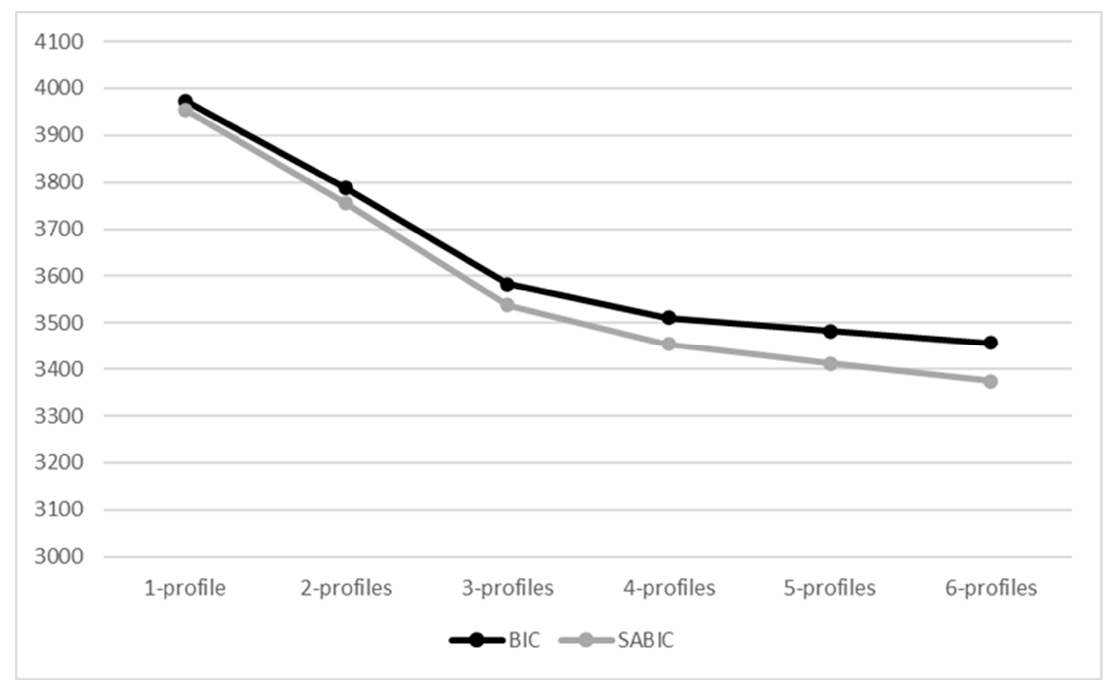
Figure A2. BIC and SABIC plots based on Time 2 LPA. Table A1. Correlations between demographic variables and latent profile indicators.